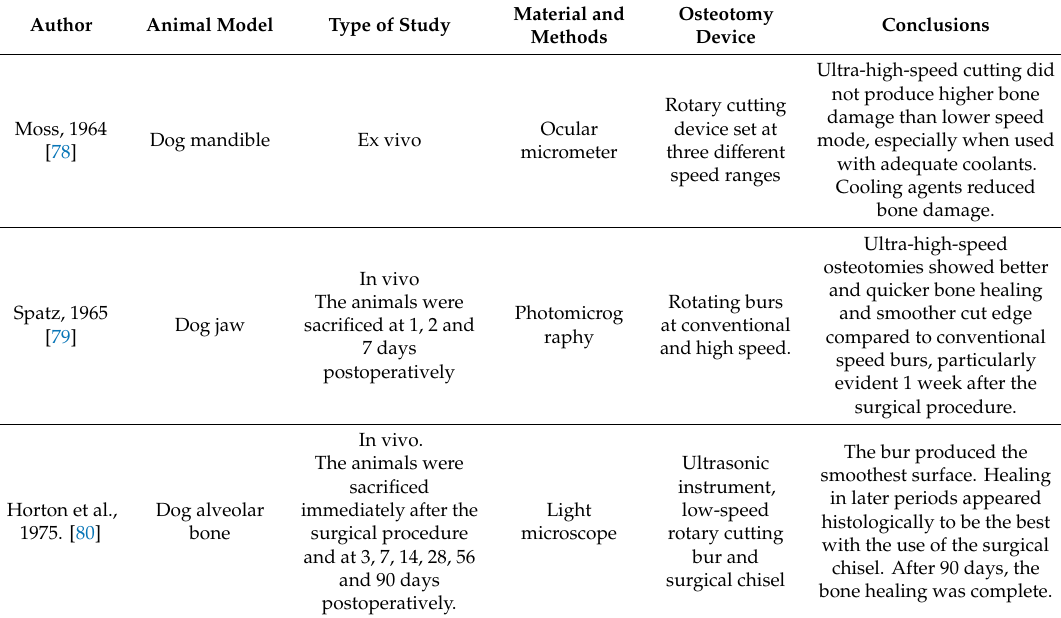
Table 4. Main animal studies on osteotomic damage available in the scientific literature.